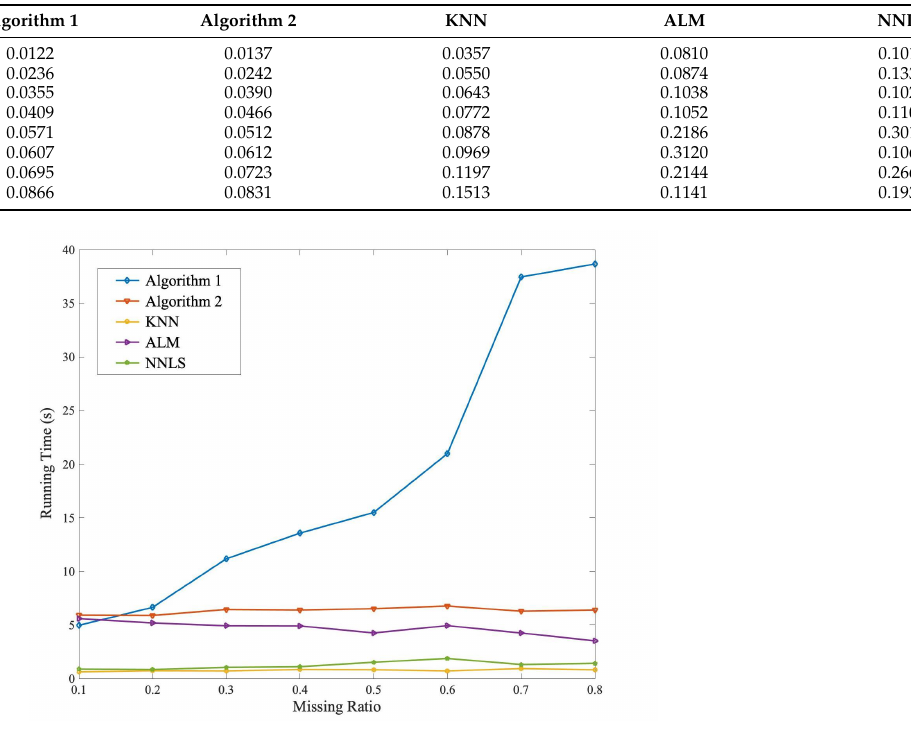
Figure 7. The running time comparison for different methods under different missing